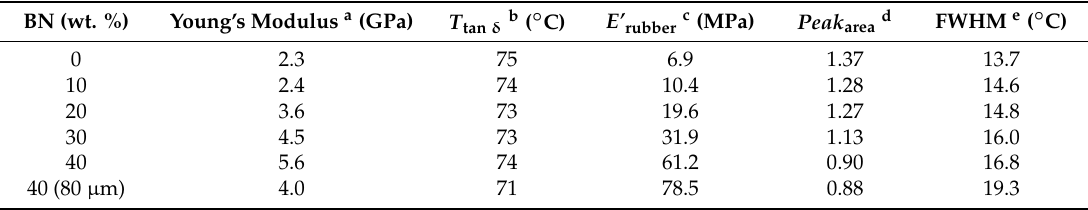
Table 4. Thermomechanical data of composites varying BN